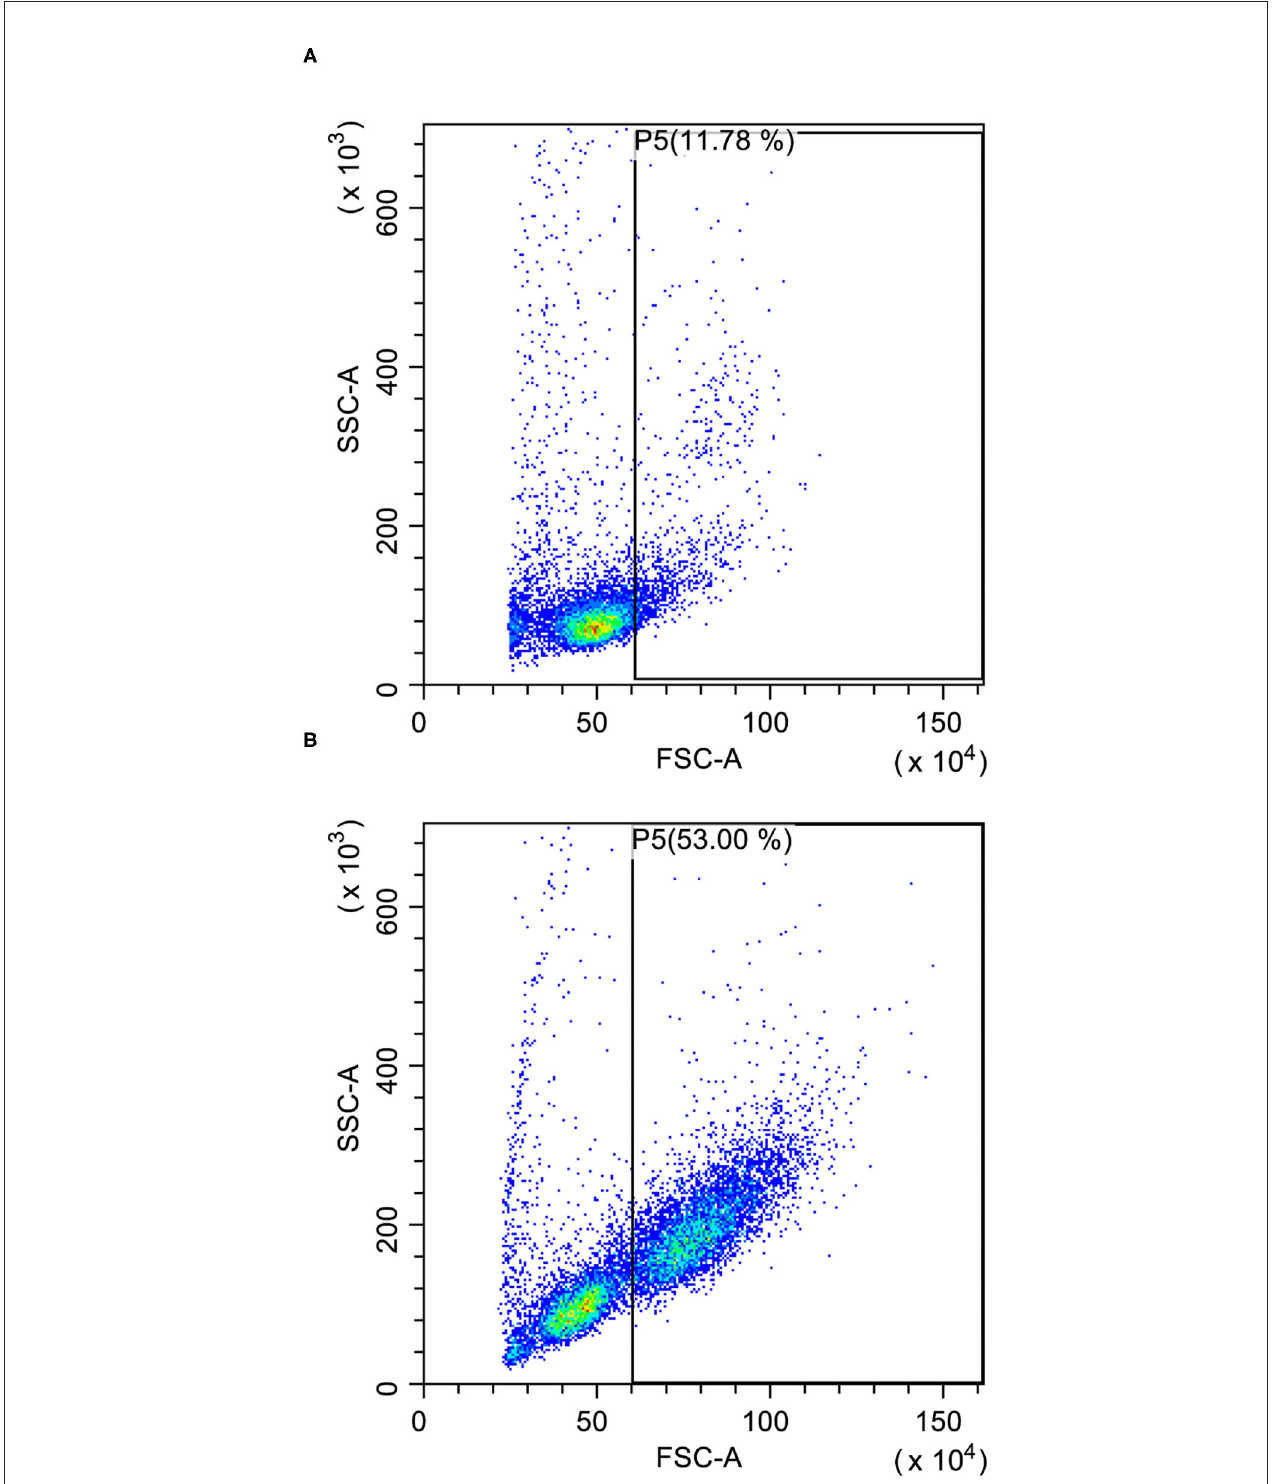
FIGURE 1 | Forward scatter (FSC) vs. side scatter (SSC) plots after doublet exclusion. (A) Reactive lymph node with few large-sized cells (P5); some granulocytes are recognizable in the gate. (B) Large B-cell lymphoma with many large-sized cells (P5) easily recognizable even in the presence of a substantial residual population of small